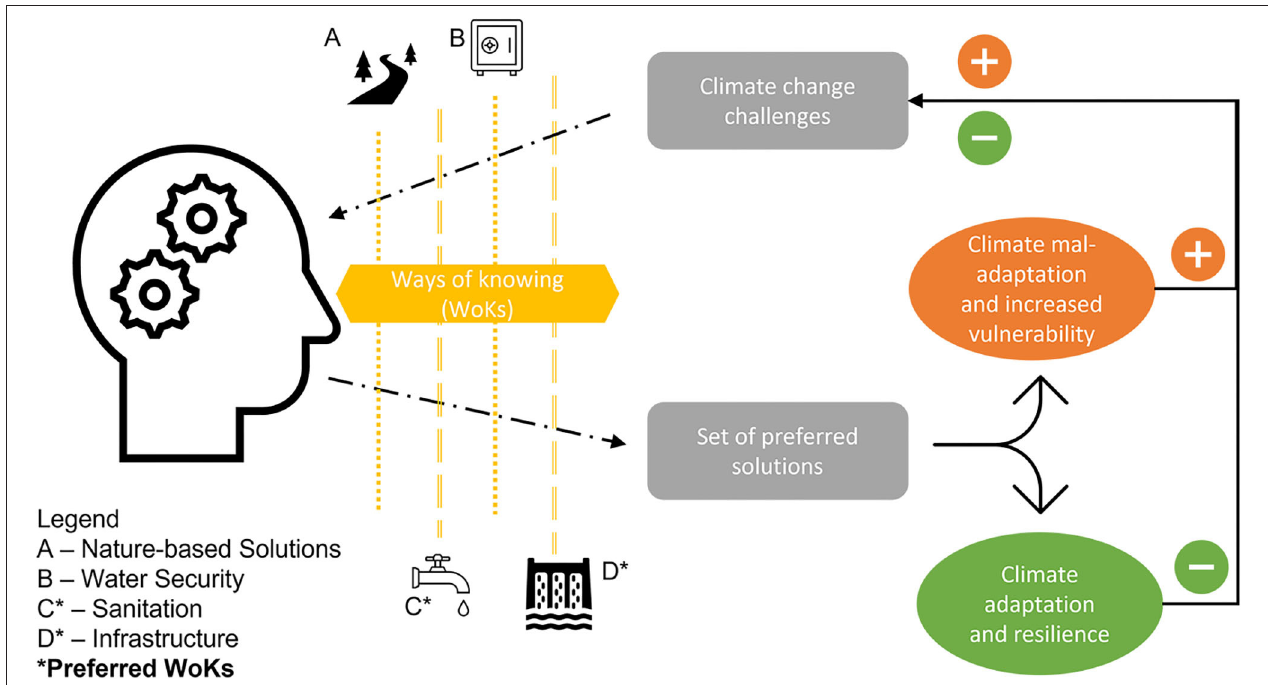
FIGURE 1 | Framework for understanding the influence of WoKs in climate adaptation and resilience